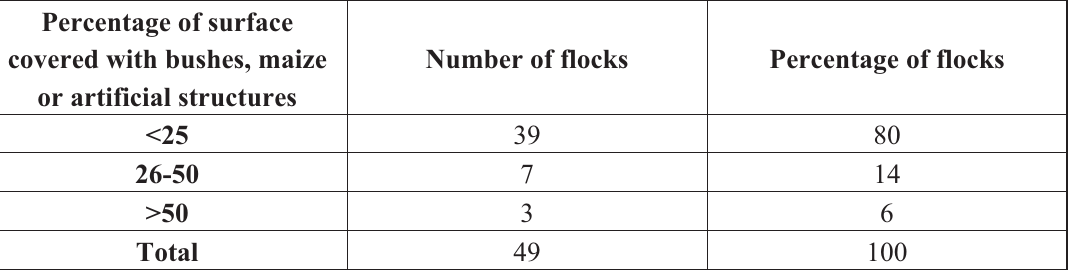
Table 4. Amount of shelter in outdoor runs.